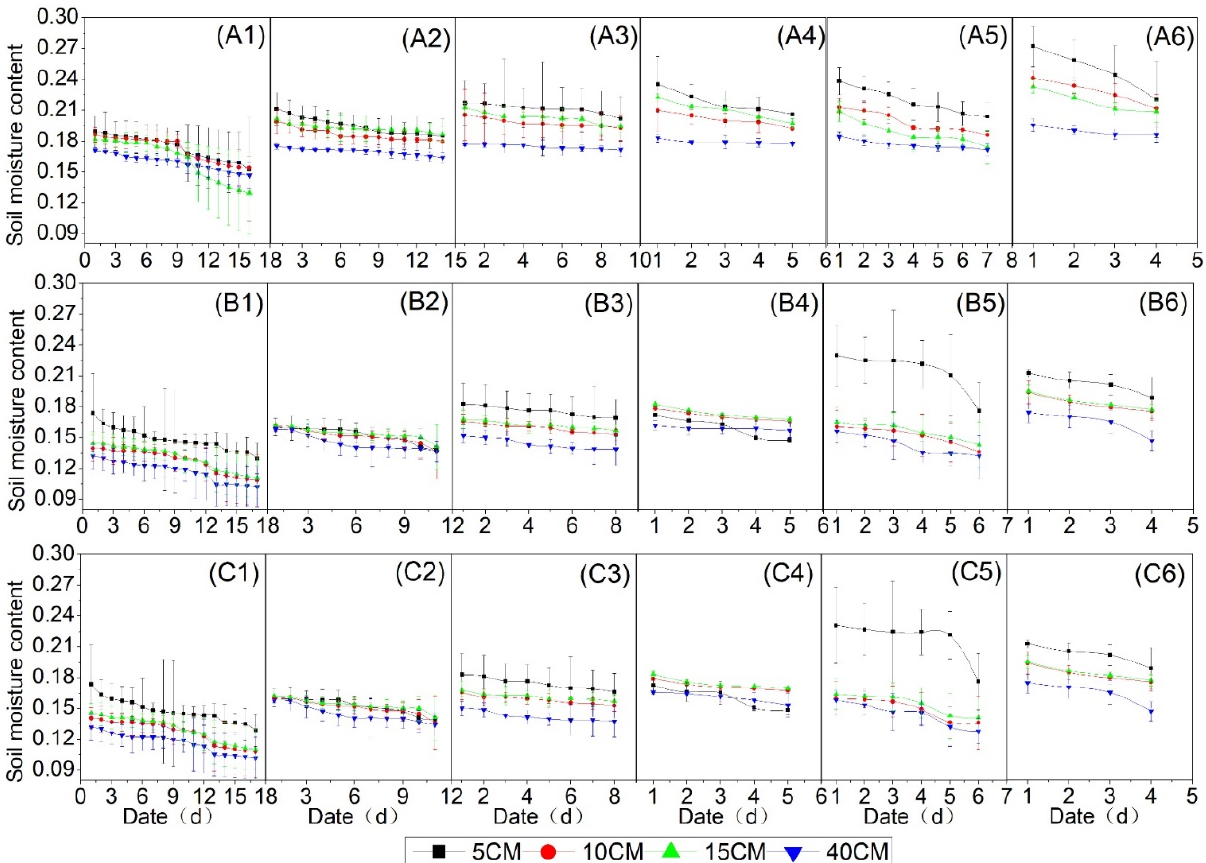
Figure 6. Variations in soil moisture content following different rainfall intensities. (Note: ( A1 – A6 ) are the variations in soil moisture content of grassland under rainfall intensities of ≤ 2 mm, 2–10 mm, 10–15 mm, 15–20 mm, 20–50 mm, and >50 mm, respectively; ( B1 – B6 ) are the variations in soil moisture content in the Q. acutissima forest under rainfall intensities of ≤ 2 mm, 2–10 mm, 10–15 mm, 15–20 mm, 20–50 mm, and >50 mm, respectively; ( C1 – C6 ) are the variations in soil moisture content in the C. lanceolata forest under rainfall intensities of ≤ 2 mm, 2–10 mm, 10–15 mm, 15–20 mm, 20–50 mm, and >50 mm,